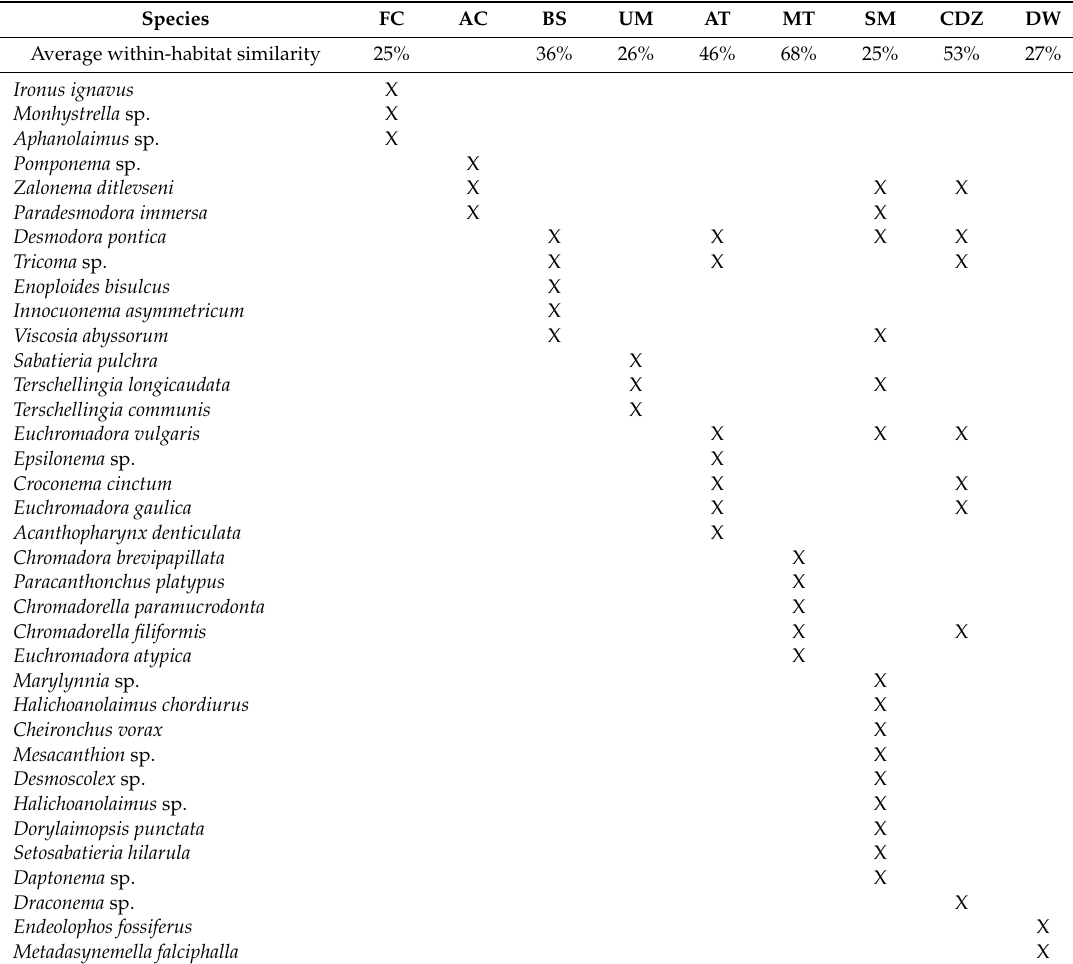
Table 1. Nematode species typical of each habitat type based on SIMPER analysis. Species were chosen by the ordered contribution to the within-habitat similarity (measured by Bray–Curtis index) and only those that contribute up to 50% of cumulative similarity were listed. Acronyms of the habitats: FC = freshwater cave, AC = anchihaline cave, BS = bare sand, UM = unvegetated mud, AT = algal turf, MT = macroalgae thallus, SM = seagrass meadow, CDZ = coral degradation zone, and DW = deep water. Species FC AC BS UM AT MT SM CDZ DW Average within-habitat similarity 25% 36% 26% 46% 68% 25% 27% Ironus ignavus X Monhystrella